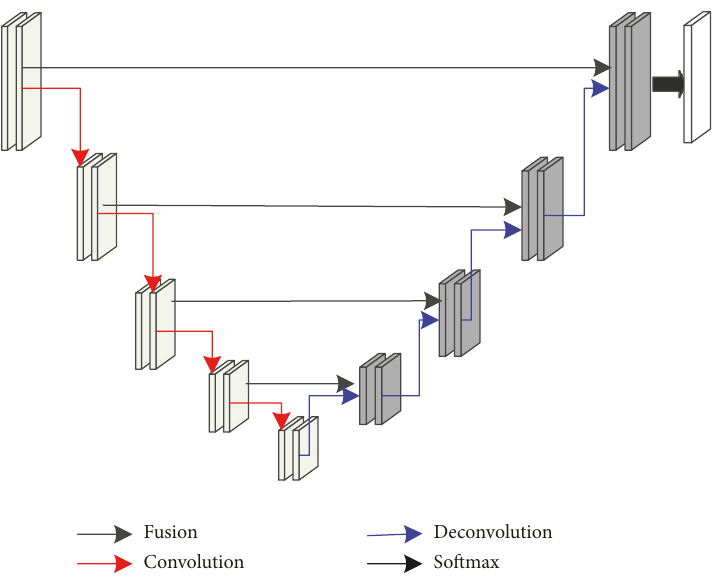
Figure 9: Architecture of